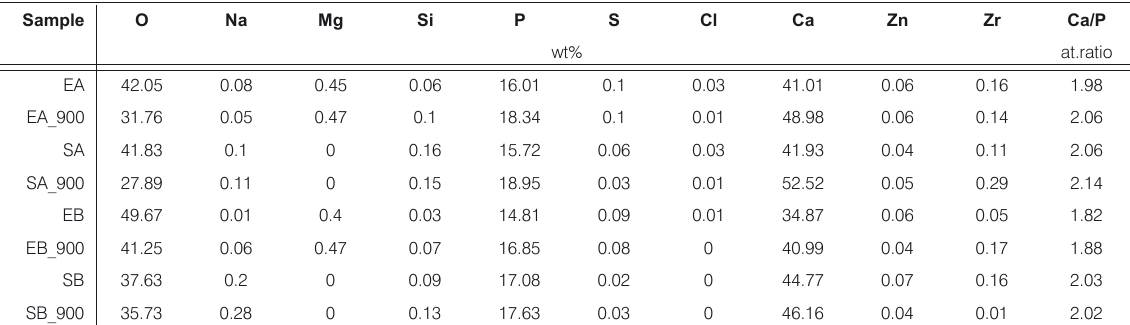
Figure 1. SEM images (a) eggshell and (b) seashell and XRD pattern of the calcinated material (c) eggshell and Table 2. Elemental composition of hydroxyapatites.